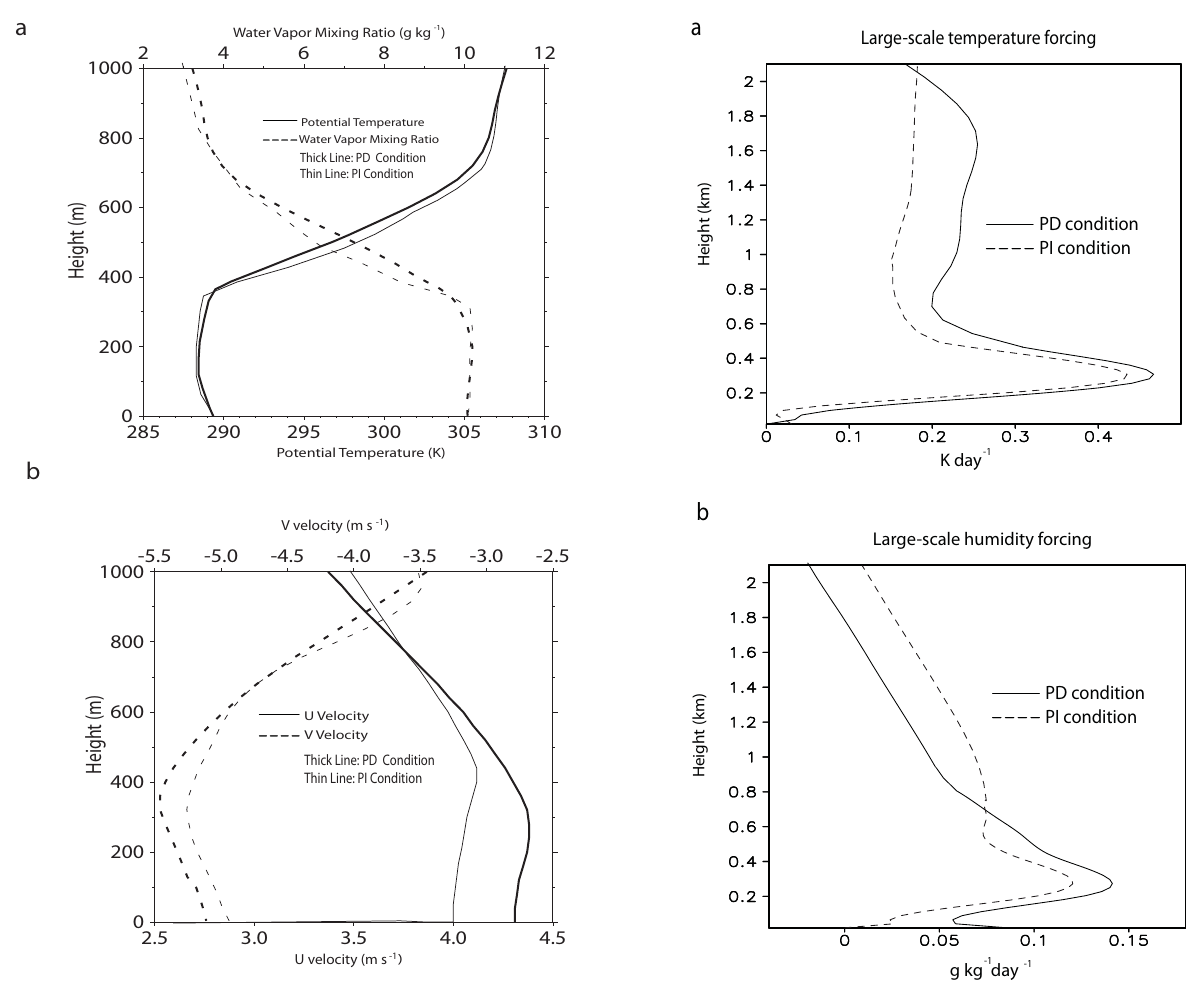
Fig. 2. Vertical distribution of the time- and area-averaged (a) po- tential temperature large-scale forcing (K day − 1 ) and (b) humidity large-scale forcing (g kg − 1 day − 1 ) for the CSRM